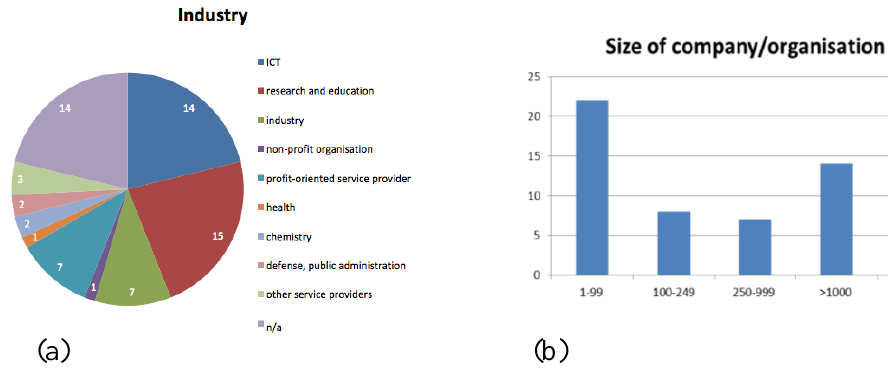
Figure 6. Industry type and company/organization size of the